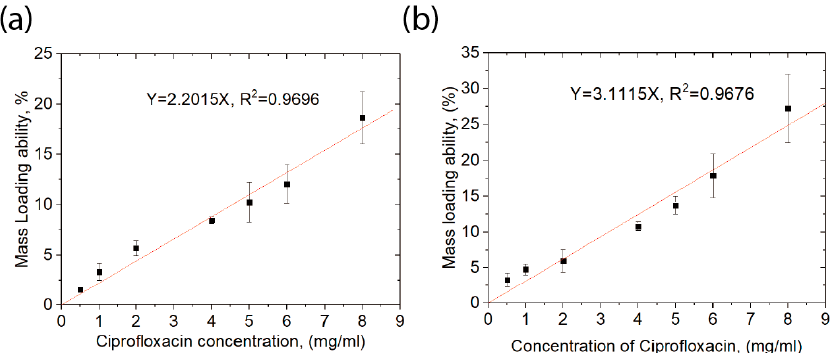
Figure 1. Relationship of NPs’ mass-loading ability and initial concentration of ciprofloxacin. ( a ) PLA-DEX NPs, y = 2.2015x, R 2 = 0.9696; ( b ) PLGA-PEG NPs, y = 3.1115x, R 2 = 0.9676. (n = 3; mean ± S.D.).